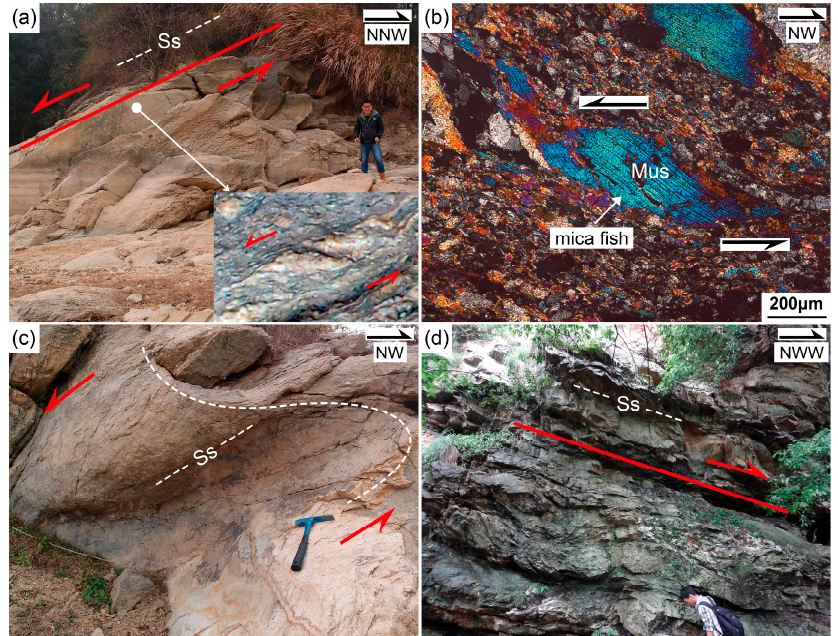
Figure 7. Field and microscopic photographs related to extensional structures. “Ss” represents mylonitic foliation, and red arrows represent motion directions in the following figures. ( a ) Tectonic gneiss zone with abundant ductile shearing phenomena in the EDF. ( b ) Mica-fish indicating a top-to-the-SE sense of shear. ( c ) Recumbent fold indicating a top-to-SSE shear sense in the EDF. ( d ) Tectonic breccias zone indicating a top-to-NWW shear sense in the WDF.